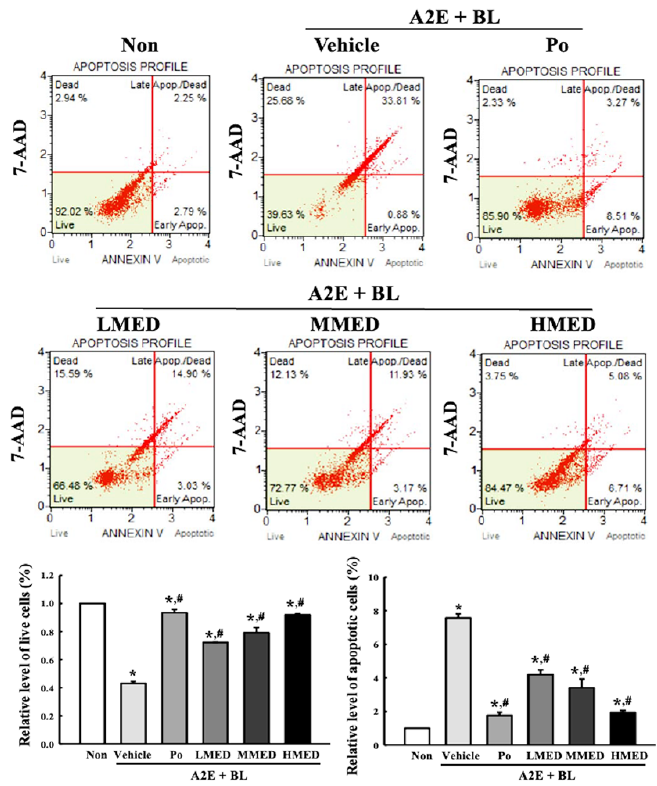
Figure 5. Apoptotic cell analysis in MED + A2E + BL treated ARPE19 cells. After staining with Annexin V and 7-AAD, the distribution of apoptotic cells was analyzed as described in materials and methods. All values in results are represented as the means ± standard deviation (SD). * indicated statically significance compared to the Non treated group, while # indicated statically significance com- pared to the Vehicle + A2E + BL treated group. Abbreviations: 7-AAD, 7-aminoactinomycin D; MED, methanol extracts of Dipterocarpus tuberculatus Roxb.; A2E: N-retinylidene-N-retinylethanolamine; BL, Blue